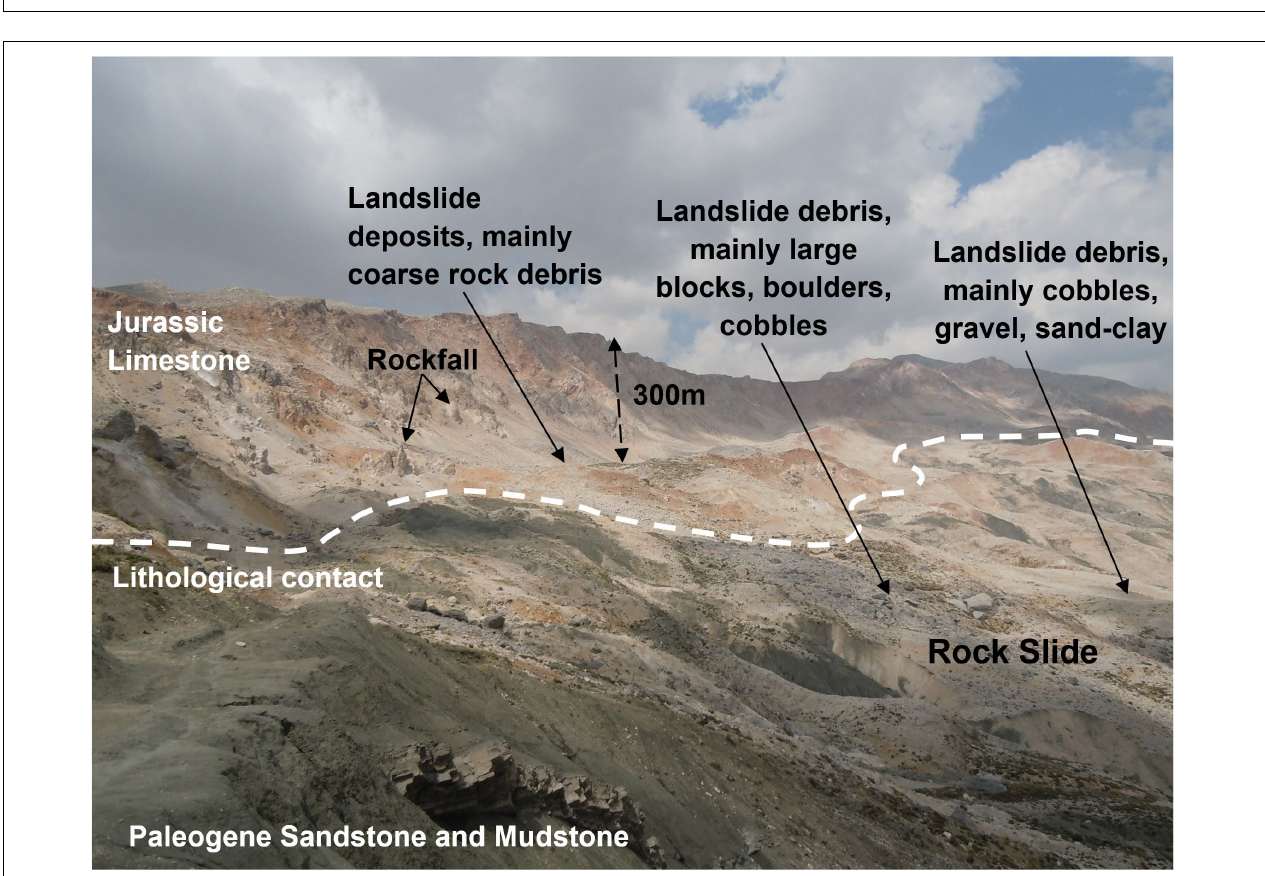
FIGURE 3 | Contact point between Jurassic limestone and Paleocene sandstone and claystone units near the head of the scarp zone of Akdag landslide complex (in Figure 1B , viewpoint of photograph is marked).